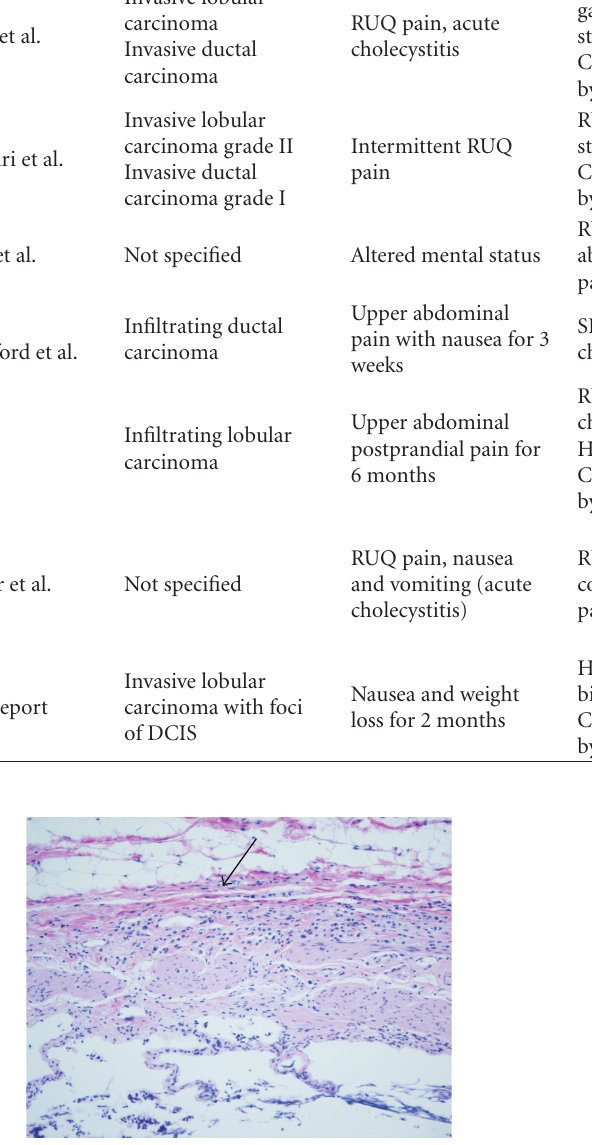
Figure 1: Invasion of the muscularis propria of the gallbladder by metastatic lobular carcinoma of the breast.